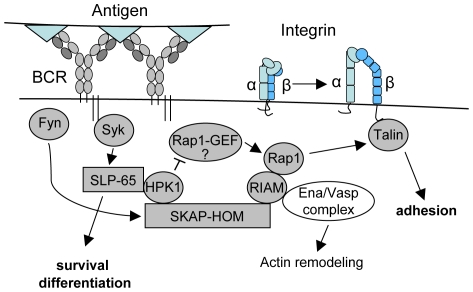
Model for HPK1 mediated negative regulation of B-cell integrin activity.Antigen receptor stimulation triggers the association of HPK1 with the two central B-cell adaptors SLP-65 [46] and likely SKAP-HOM, which regulate cellular survival/differentiation and adhesion. In this context, we suggest HPK1 to act as a dual regulator by shaping SLP-65 mediated signals and restricting Rap1 activation required for B-lymphocyte adhesion; SLP-65, Src homology 2 domain-containing leukocyte protein of 65 kDa; Syk, spleen tyrosine kinase.